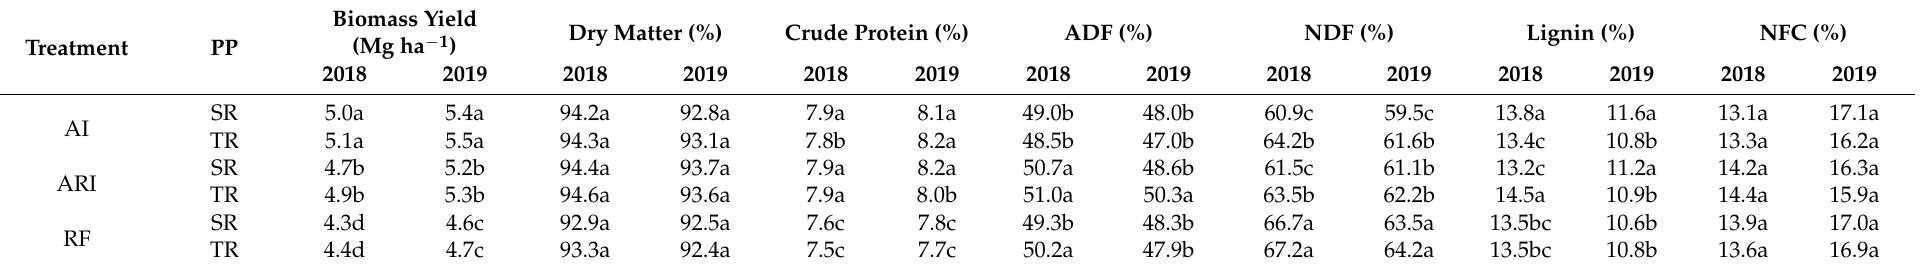
Table 2. Effect of irrigation treatments (AI, ARI, and RF) and planting pattern (SR, single-row and TR, twin-row) on soybean biomass yield and composition. PP: Planting pattern; AI is all-row irrigation, ARI is alternate row irrigation, and RF is rainfed.